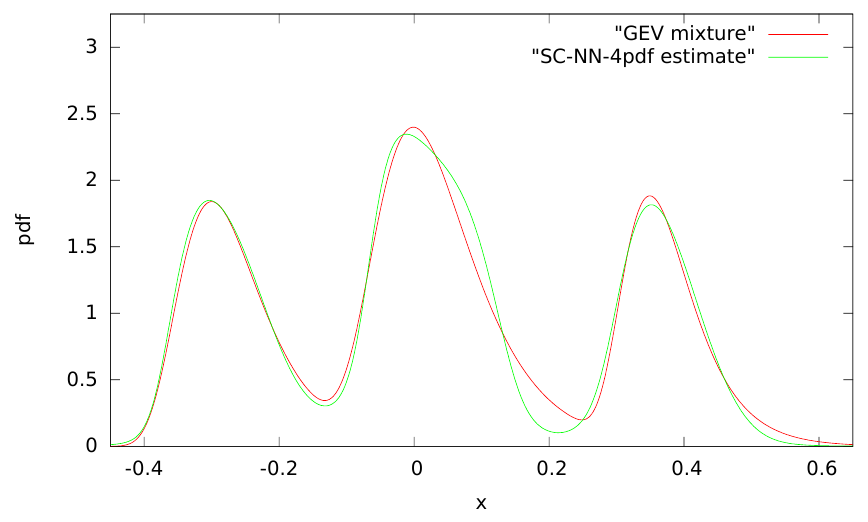
Figure 1. SC-NN-4pdf estimate of a mixture of GEV pdfs ( n =